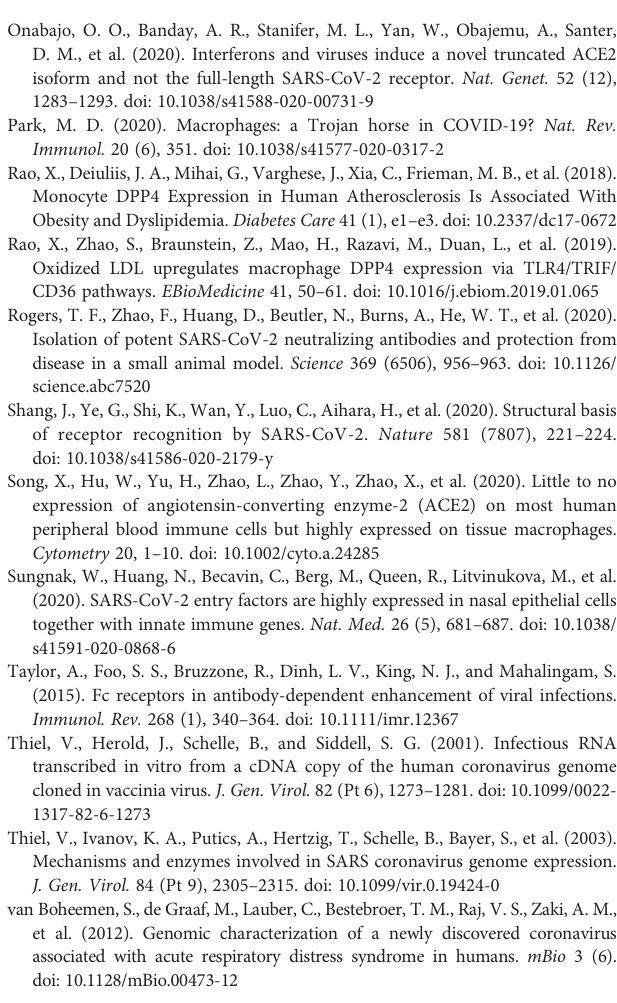
Supplementary Figure 1 | Positive control experiment for ADE with hMDM. Serum from pig vaccinated with an experimental JEV vaccine (red) and naïve serum (black) were ten-fold diluted (from 1:10 to 1:10000) and incubated with JEV Laos at MOIof1 TCID50/ml for 30,thenimmune complexes wereincubated withhMDMfor another 30 min, after wash and incubation for 24 h, infected cells were quanti fi ed by fl ow cytometry. Data from four independent experiments run in triplicates are shown. Each symbol represents the average value of infection in hMDM from a different donor. Statistically signi fi cant differences are indicated by asterisks (*p < 0.05, **p ≤ 0.002, and ***p ≤